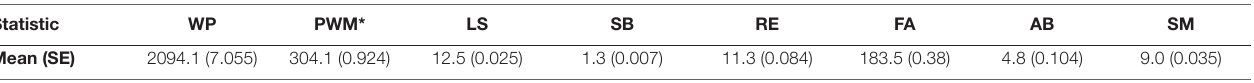
taBle 1 | Mean baseline estimates for weaned pigs production and performance indicators statistic